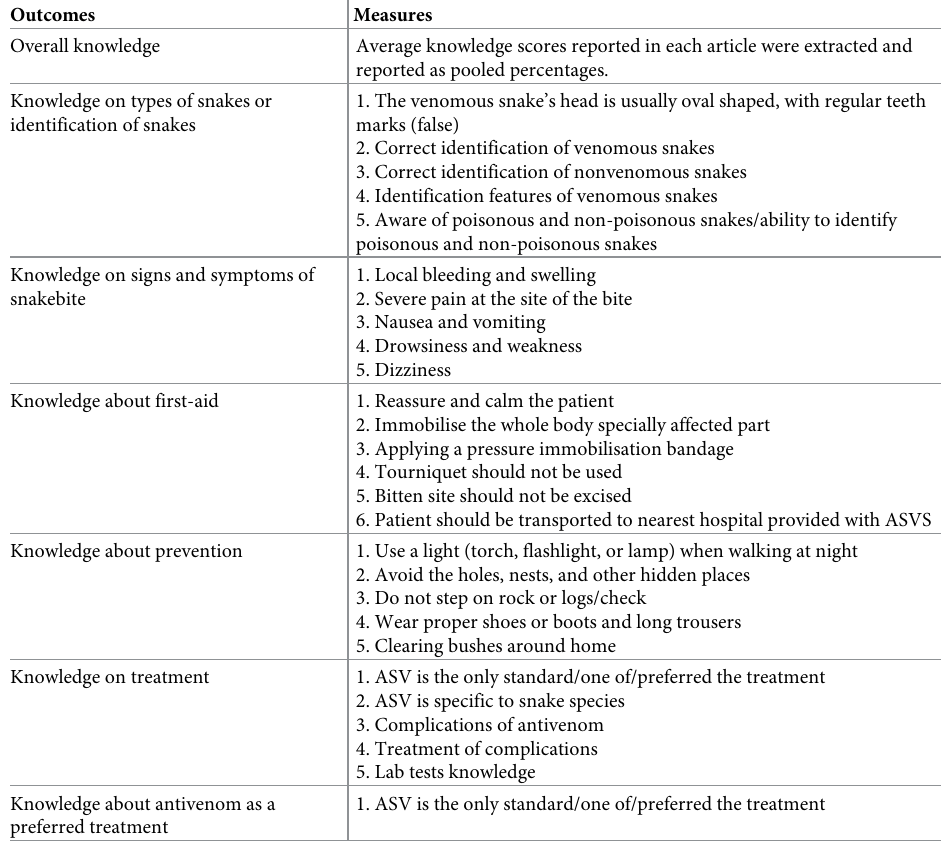
Table 2. Description of the outcome